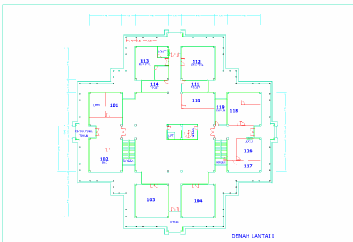
Figure 1. Floor plan for Library building at